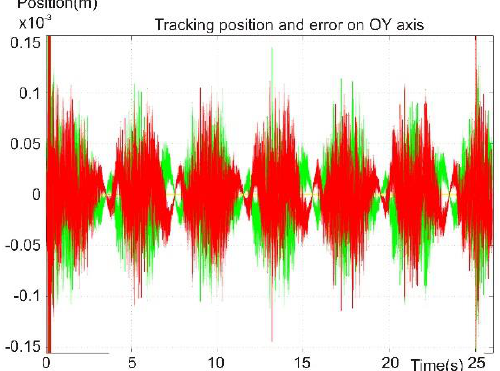
Figure 19. Foot tracking position on the OY axis.